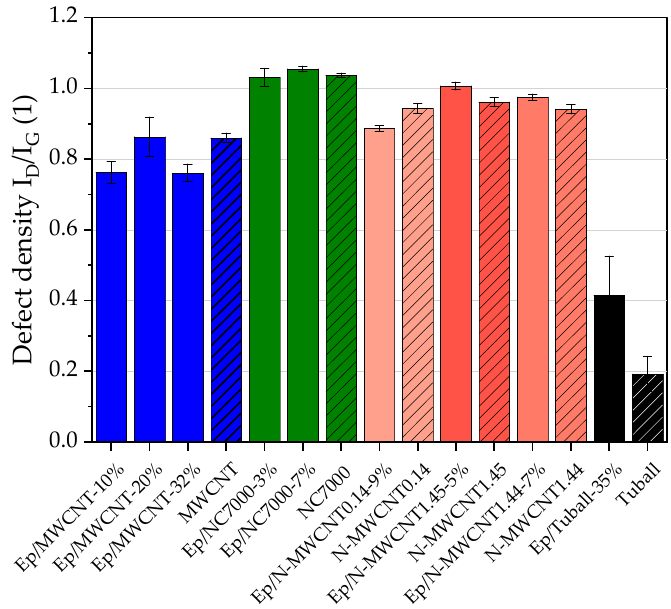
Figure A1. Defect density expressed as the ratio of I D / I G from RAMAN investigations of in lab-made undoped MWCNTs, commercial undoped MWCNTs, lab-made nitrogen doped MWCNTs, commercial SWCNT and their composites.